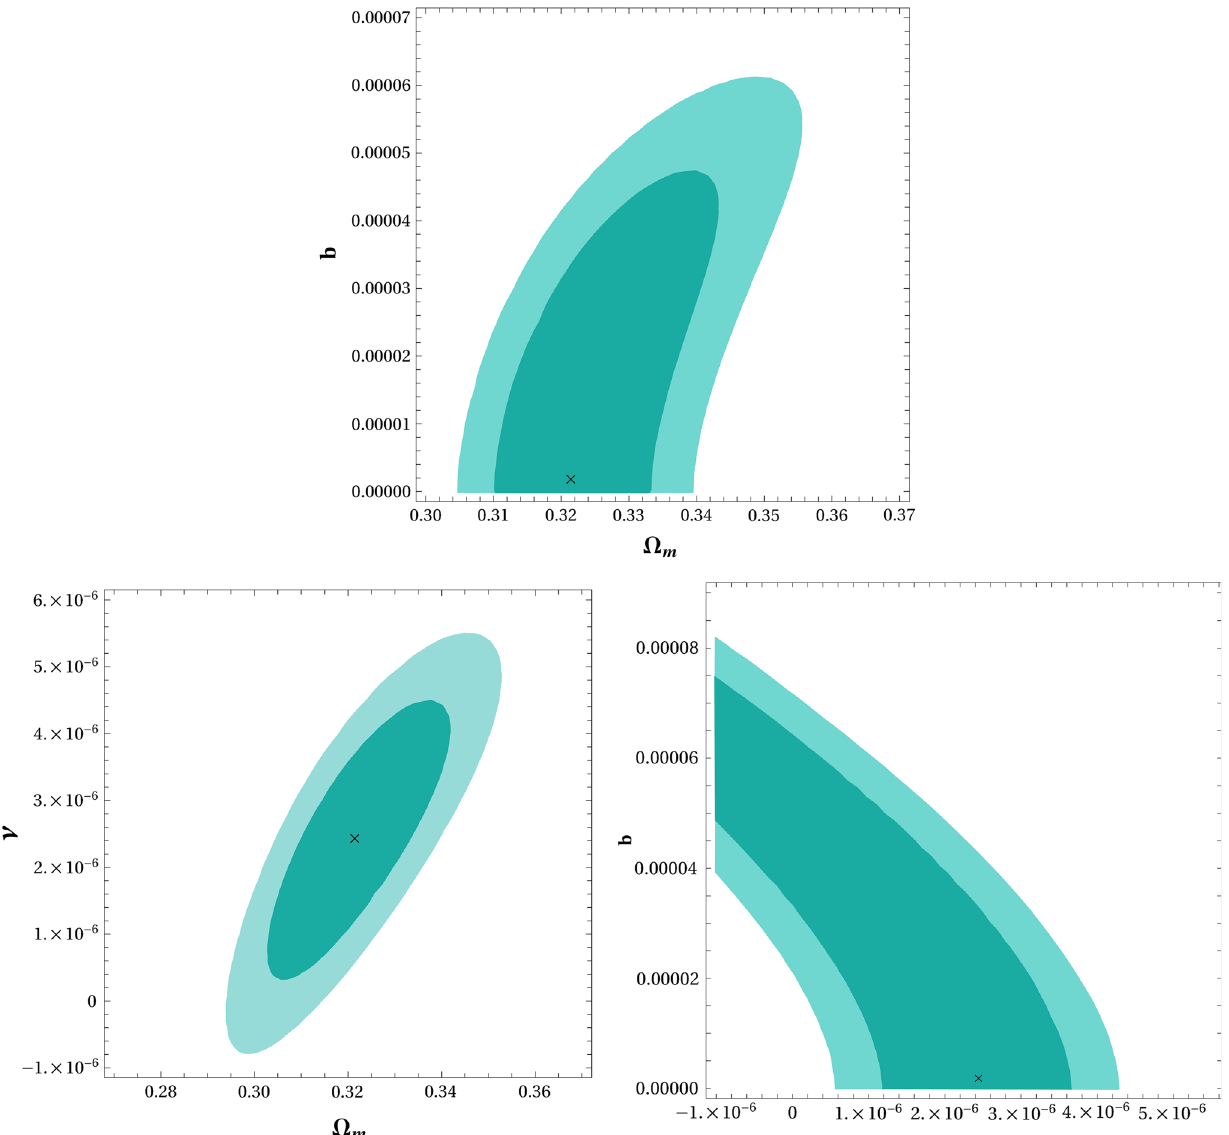
Fig. 5 Observational constraints for our three free parameters ν , b and (cid:9) 0 m , for 1 σ and 2 σ levels. Here we have used SNIa+BAO+CMB combined data. The marked points are given by ( ¯ (cid:9) 0 m , ¯ b ) , ( ¯ (cid:9) 0 m ,ν) and ( ¯ ν, ¯ b ) , respectively, in correspondence with best fit values presented above in Table